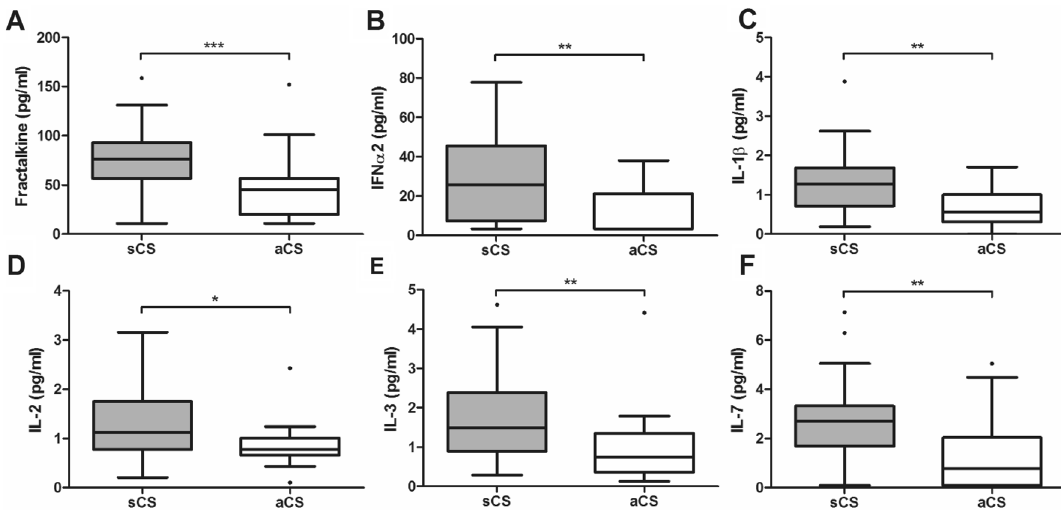
Figure 2. Differences of cytokine concentrations between patients with symptomatic and asymptomatic carotid stenosis. Boxplots depicting a comparison of plasma cytokine levels in patients with symptomatic (sCS) and asymptomatic carotid stenosis (aCS). After correction for multiple comparisons and adjustment for possible confounders significant differences were observed concerning Fractalkine ( A ), IFN-α2 ( B ), IL-1β ( C ), IL-2 ( D ), IL-3 ( E ), IL-7 ( F ). Asterisks refer to univariable analysis (***p < 0.001; **p < 0.01; *p < 0.05).